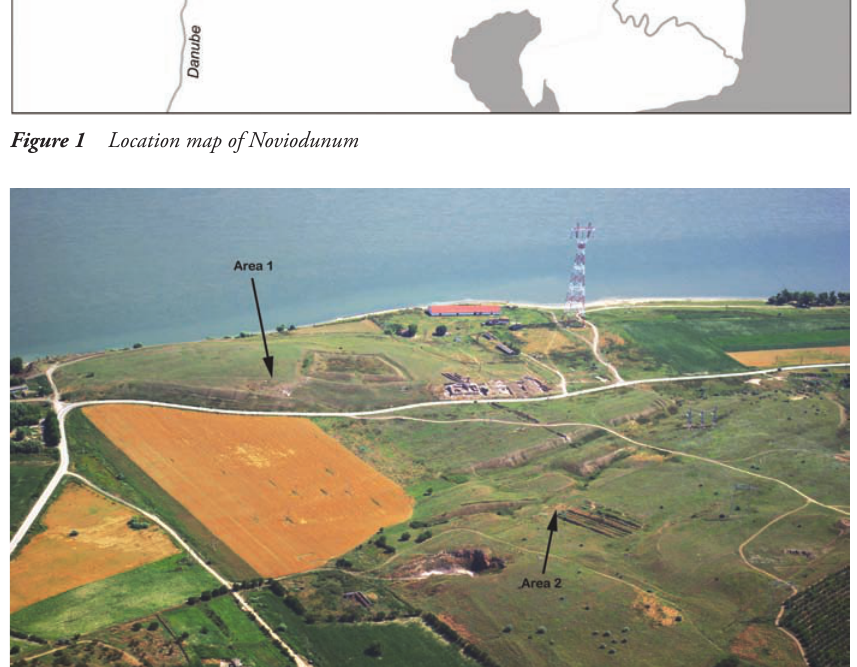
Figure 2 Aerial phtograph of the